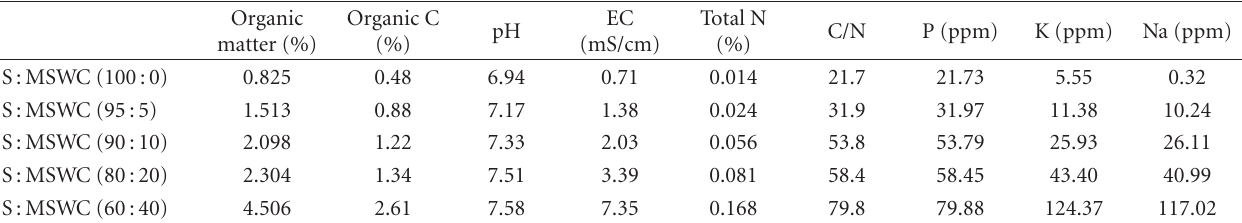
Table 1: Physicochemical properties of substrate medium consisted of soil (S) and municipal solid waste compost (MSWC) resulted in five